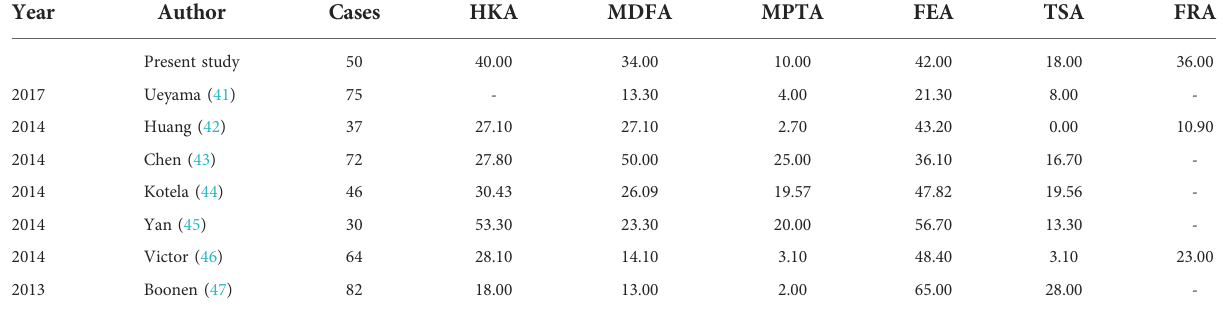
TABLE 6 Comparison of outlier rates from published studies